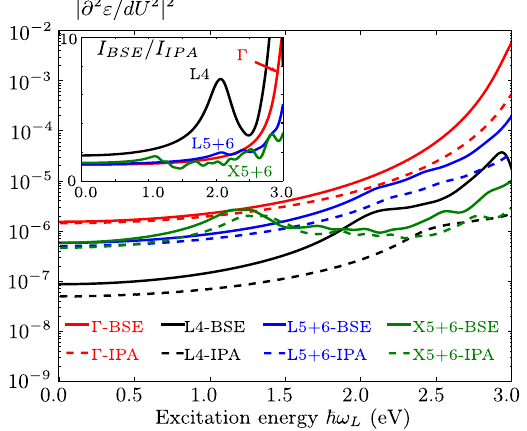
Figure 8. Second derivatives of the dielectric function with respect to the excitation energy for the highest- energy modes at Γ , X and L as well as the fourth mode at the L point. The inset shows the ratio between the BSE and the IPA